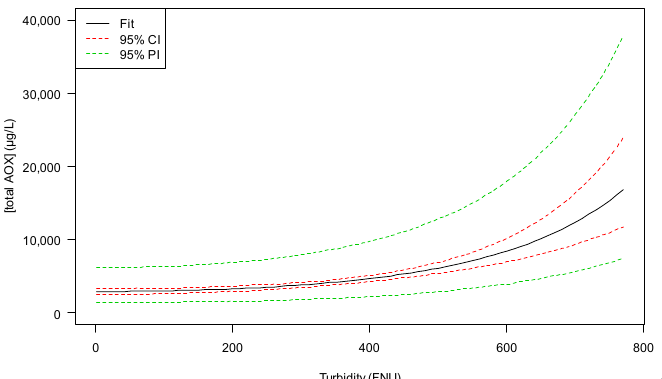
Figure 7. Confidence (CI) and prediction intervals (PI) for each individual predictor variable for the model predicting the total AOX concentration: ( a ) absorbance at 227 nm; ( b ) absorbance at 200 nm and ( c ) turbidity.